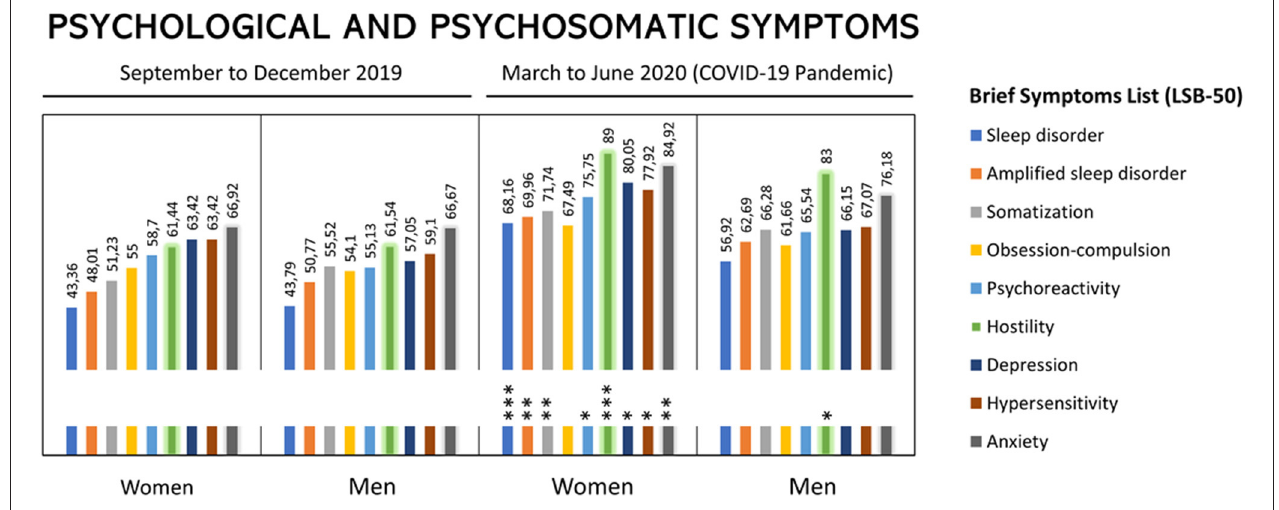
FIGURE 2 | Changes in the Psychological and Psychosomatic Symptoms during the confinement (Barcelona, March to June, 2020) due to COVID-19 pandemic in with women and men with a positive diagnosis of misophonia. Results are expressed as percentiles. Brief symptoms list (LBS-50) as provided in the legend. Asterisks refer to symptoms that increased dramatically in the second period of the